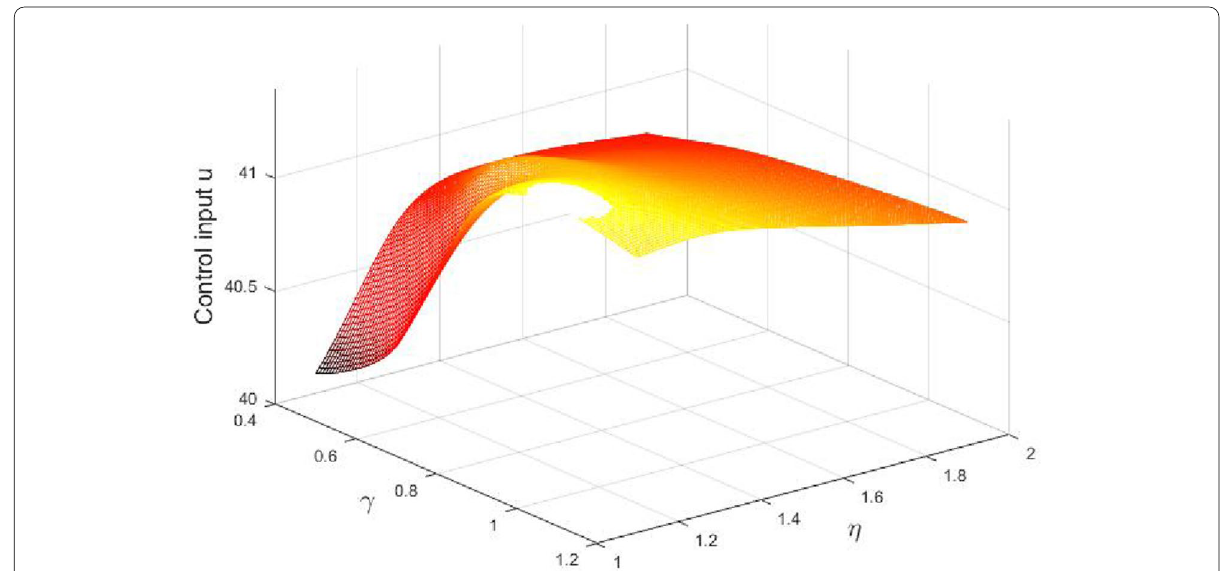
Figure 11 Relation between control input u , γ and